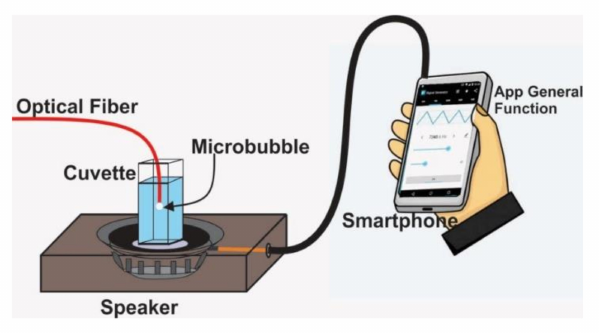
Figure 7. Experimental setup of a vibration sensor based in Doppler